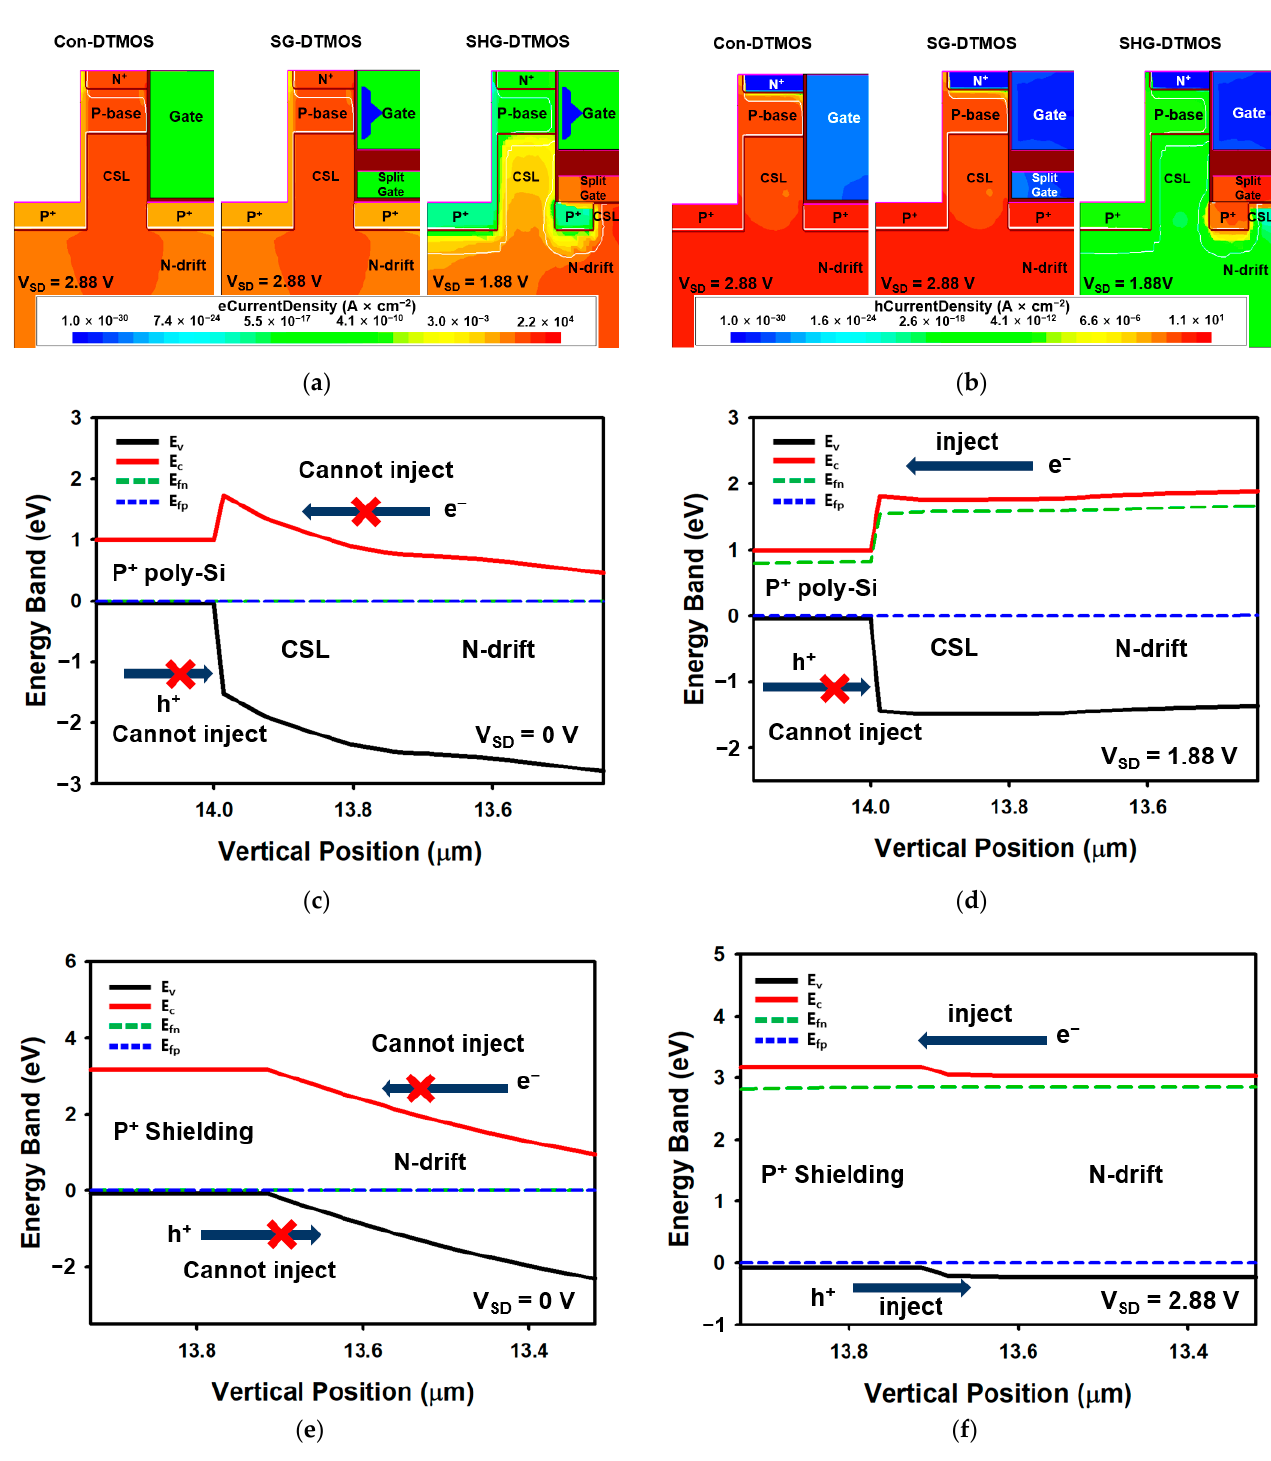
( b ) Figure 7. ( a ) Test circuit of reverse recovery charge and switching characteristics. ( b ) Comparison of body diodes reverse recovery characteristics of Con-DTMOS, SG-DTMOS, and SHG-DTMOS.